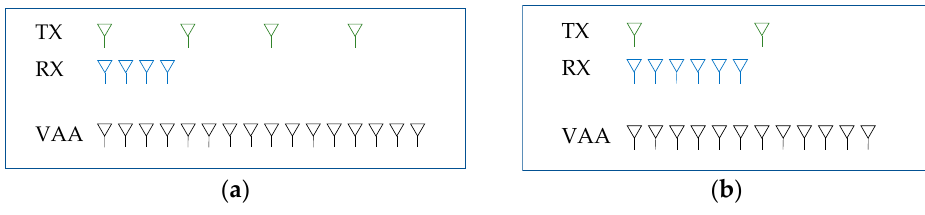
Figure 3. VAA configuration with eight arrays: ( a ) four Tx and four Rx (left) ( b ) two Tx and six Rx (right).